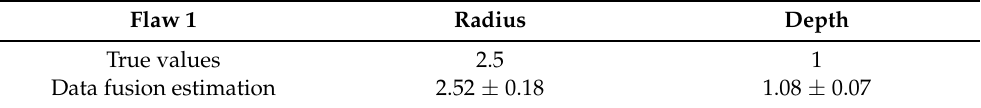
Table 2. ANNs estimations of radii and depths (mm) obtained for the first measured flaw.